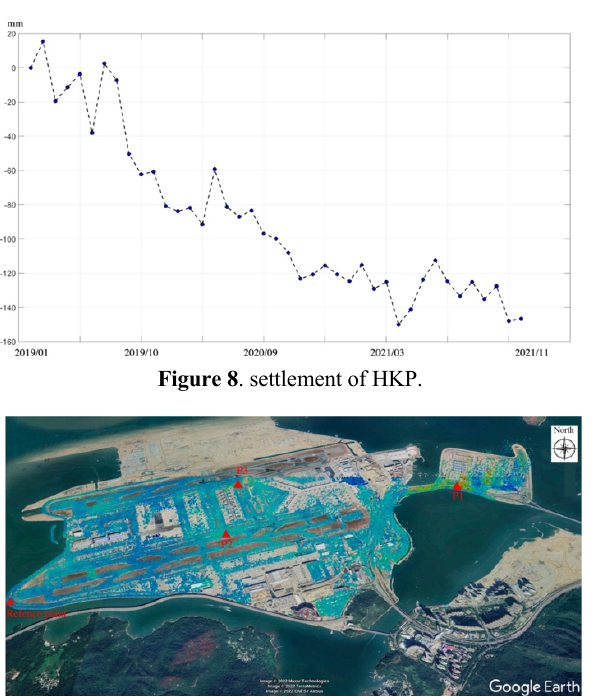
Figure 9 . Estimated overall settlement velocity over the two years.